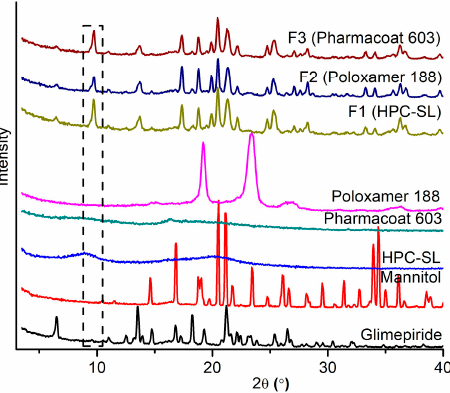
Figure 5. Powder X-ray diffraction (PXRD) patterns of raw materials and spray dried nanosuspensions.